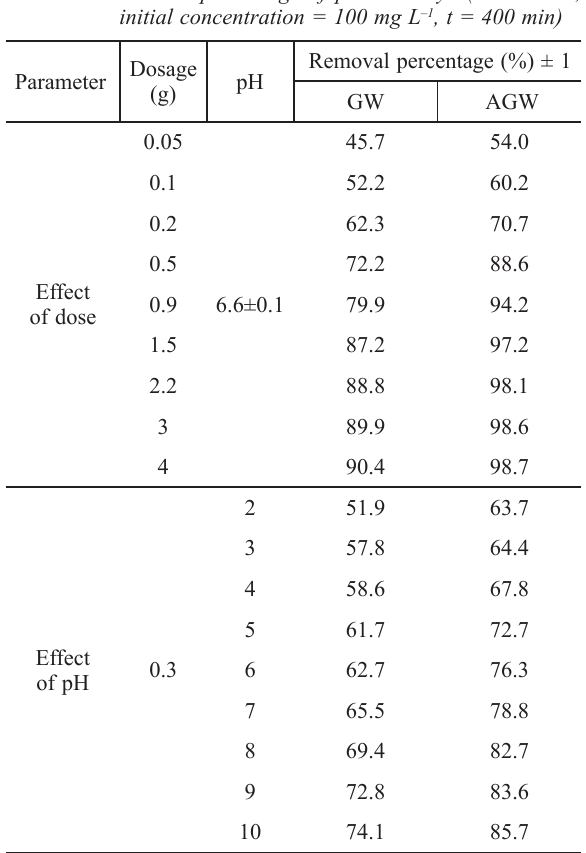
Table 2 – Effect of adsorbent dosage and initial pH on the removal percentage of pollutant dye (T = 30